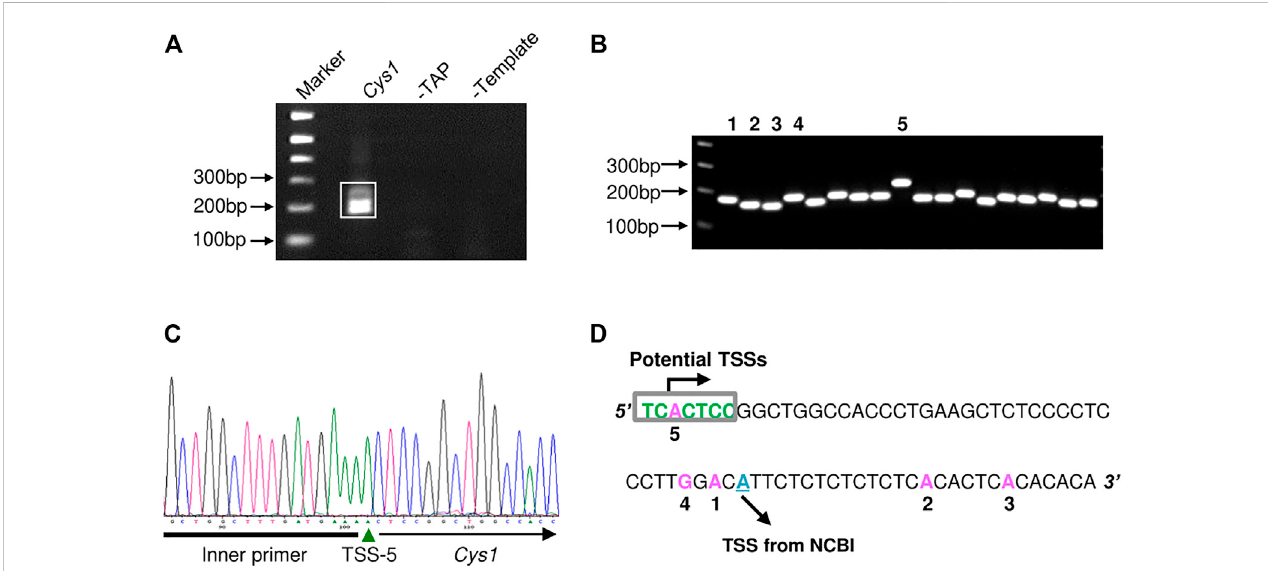
Determination of the Cys1 transcription start site (TSS) using 5 ′ RACE. (A) Agarose gel electrophoresis of Cys1 5 ′ RACE PCR products. The boxed PCR reaction products (lane Cys1 )were cloned and sequenced. Remaining lanes show the results of negative control PCR reactions: middle lane, template mRNA was not decapped by TAP treatment (-TAP, a negative control for RACE); right lane, non-reverse transcribed mRNA subjected directly to PCR (-Template, a negative control for PCR ampli fi cation). (B) Individual colony-based PCR reaction products generated using cloned Cys1 amplicon plasmid DNA as template. Clones 1 – 5 were analyzed by DNA sequencing. (C) Clone 5 DNA sequencing data. Inner primer indicates sequence corresponding to the 5 ′ RACE adaptor primer from the FirstChoice RLM-RACE kit. (D) Locations of TSS from the fi ve clones are shown in pink; initiator consensus sequence [PyPyAN